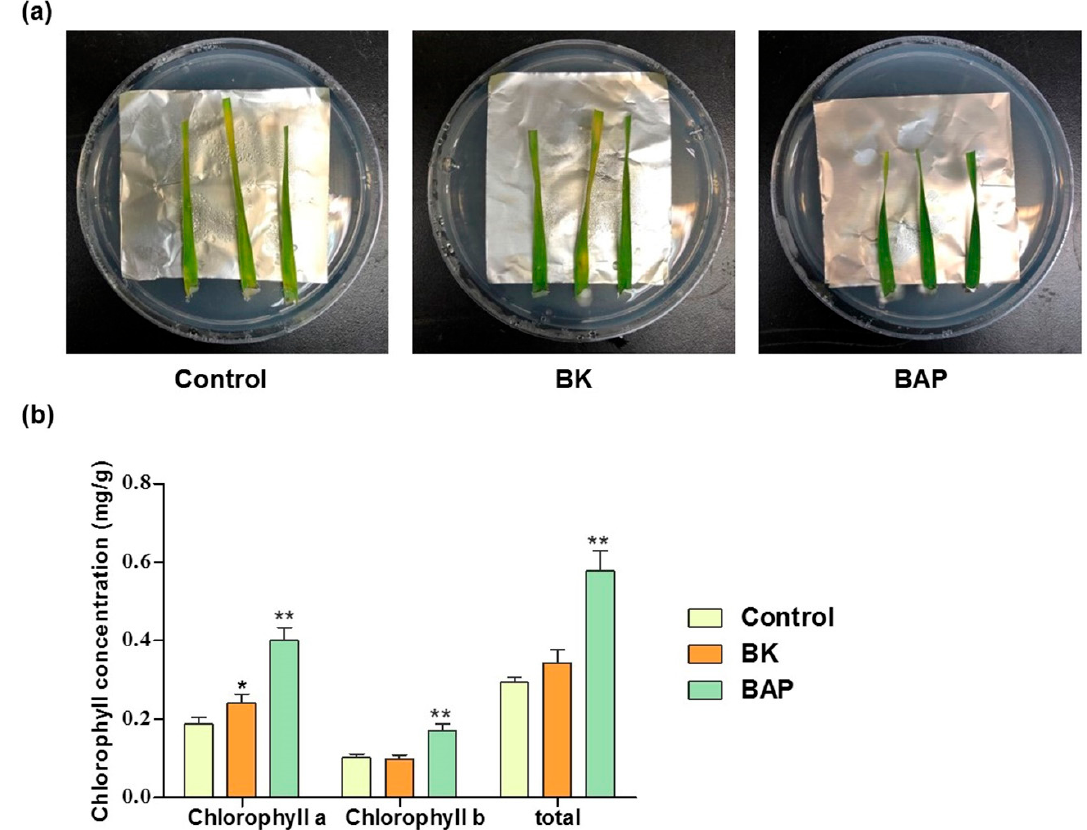
Figure 1. Comparison of senescence of detached Keumkang wheat leaves grown on defined medium containing chemical retardants, the BK (Benzimidazole + kinetin) or the BAP (6-Benzylaminopurine) medium. ( a ) Morphologies and ( b ) chlorophyll contents in detached leaves of 14-days-old seedlings of the common wheat grown on the three types of media for 7 days. BK contains kinetin and benzimidazole, and BAP contains 6-benzylaminopurine. Asterisks indicate significant differences compared to control in each type. Error bars represent standard deviation ( n = 3). Data were statistically analyzed by a Student’s t -test (*: p < 0.05, **: p < 0.01).